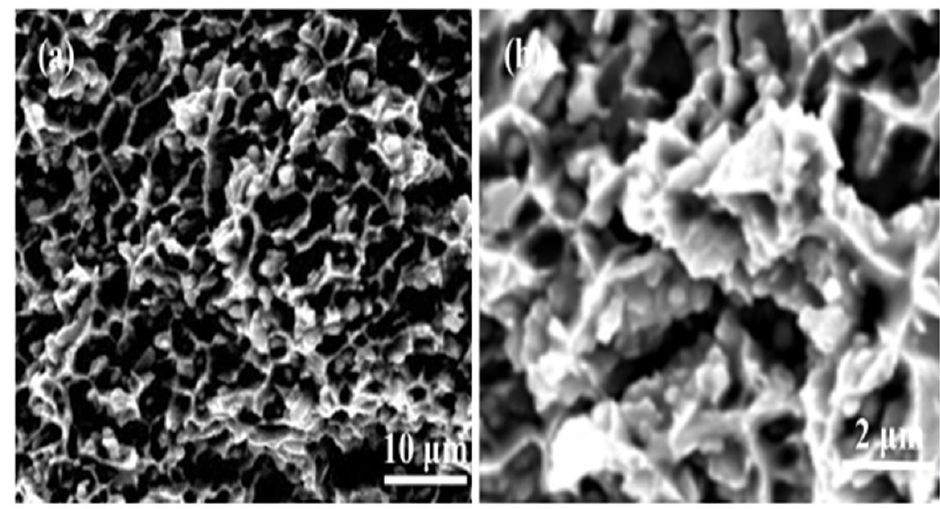
Figure 7. Fracture morphology of as-extruded sample (a) at lower magnification, (b) at higher